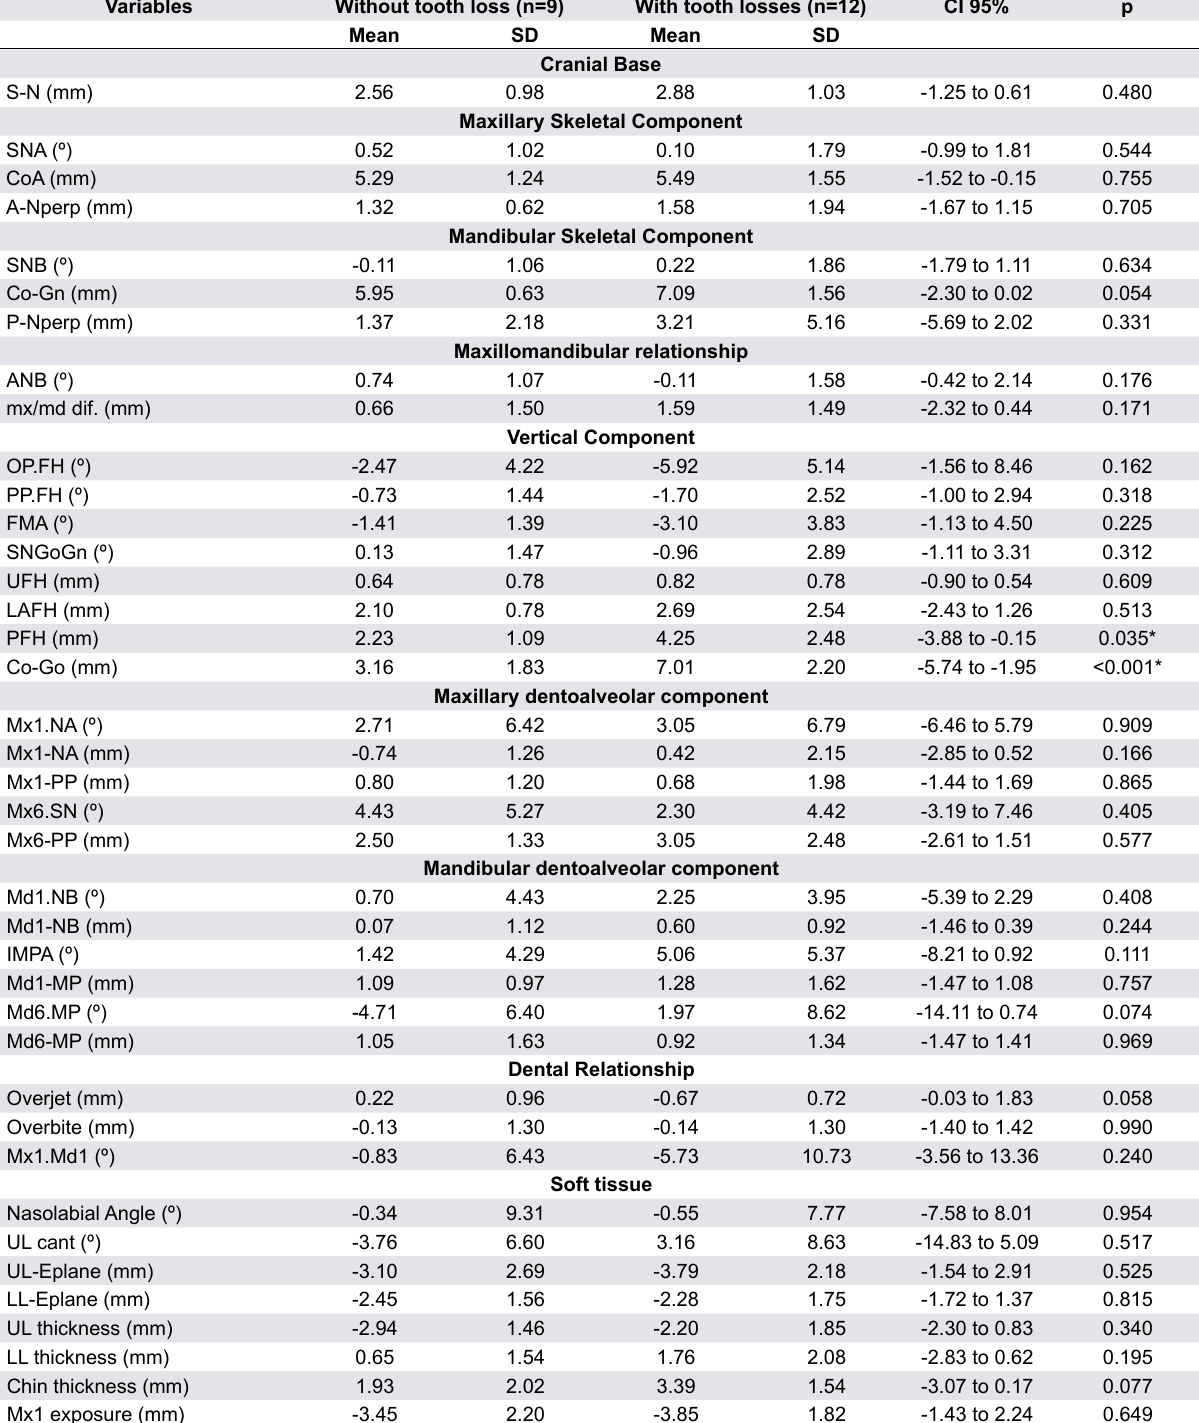
Table 4- Comparison between subgroups with and without tooth loss